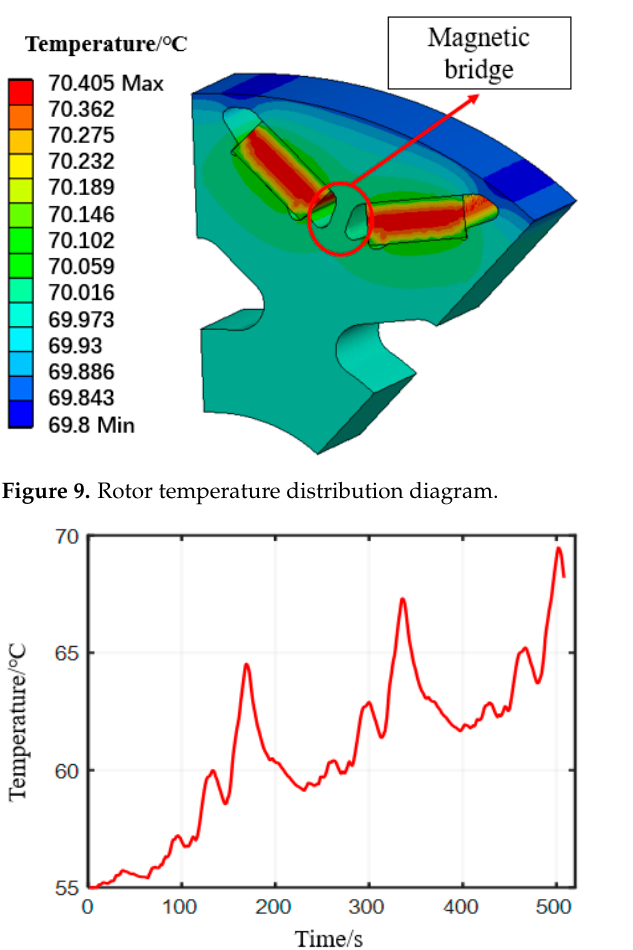
Figure 10. Temperature variation at the rotor spacer bridge.